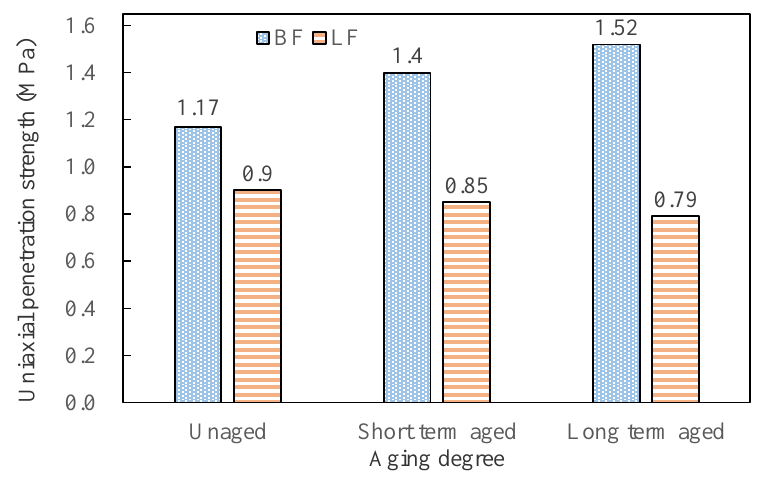
Figure 5. Results of uniaxial penetration strength.